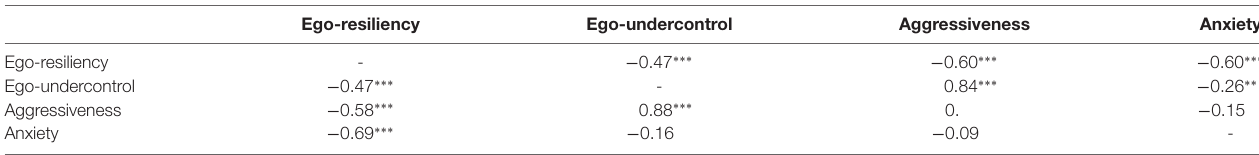
TABLE 1 | Correlations between CCQ personality variables at ages six and 12.